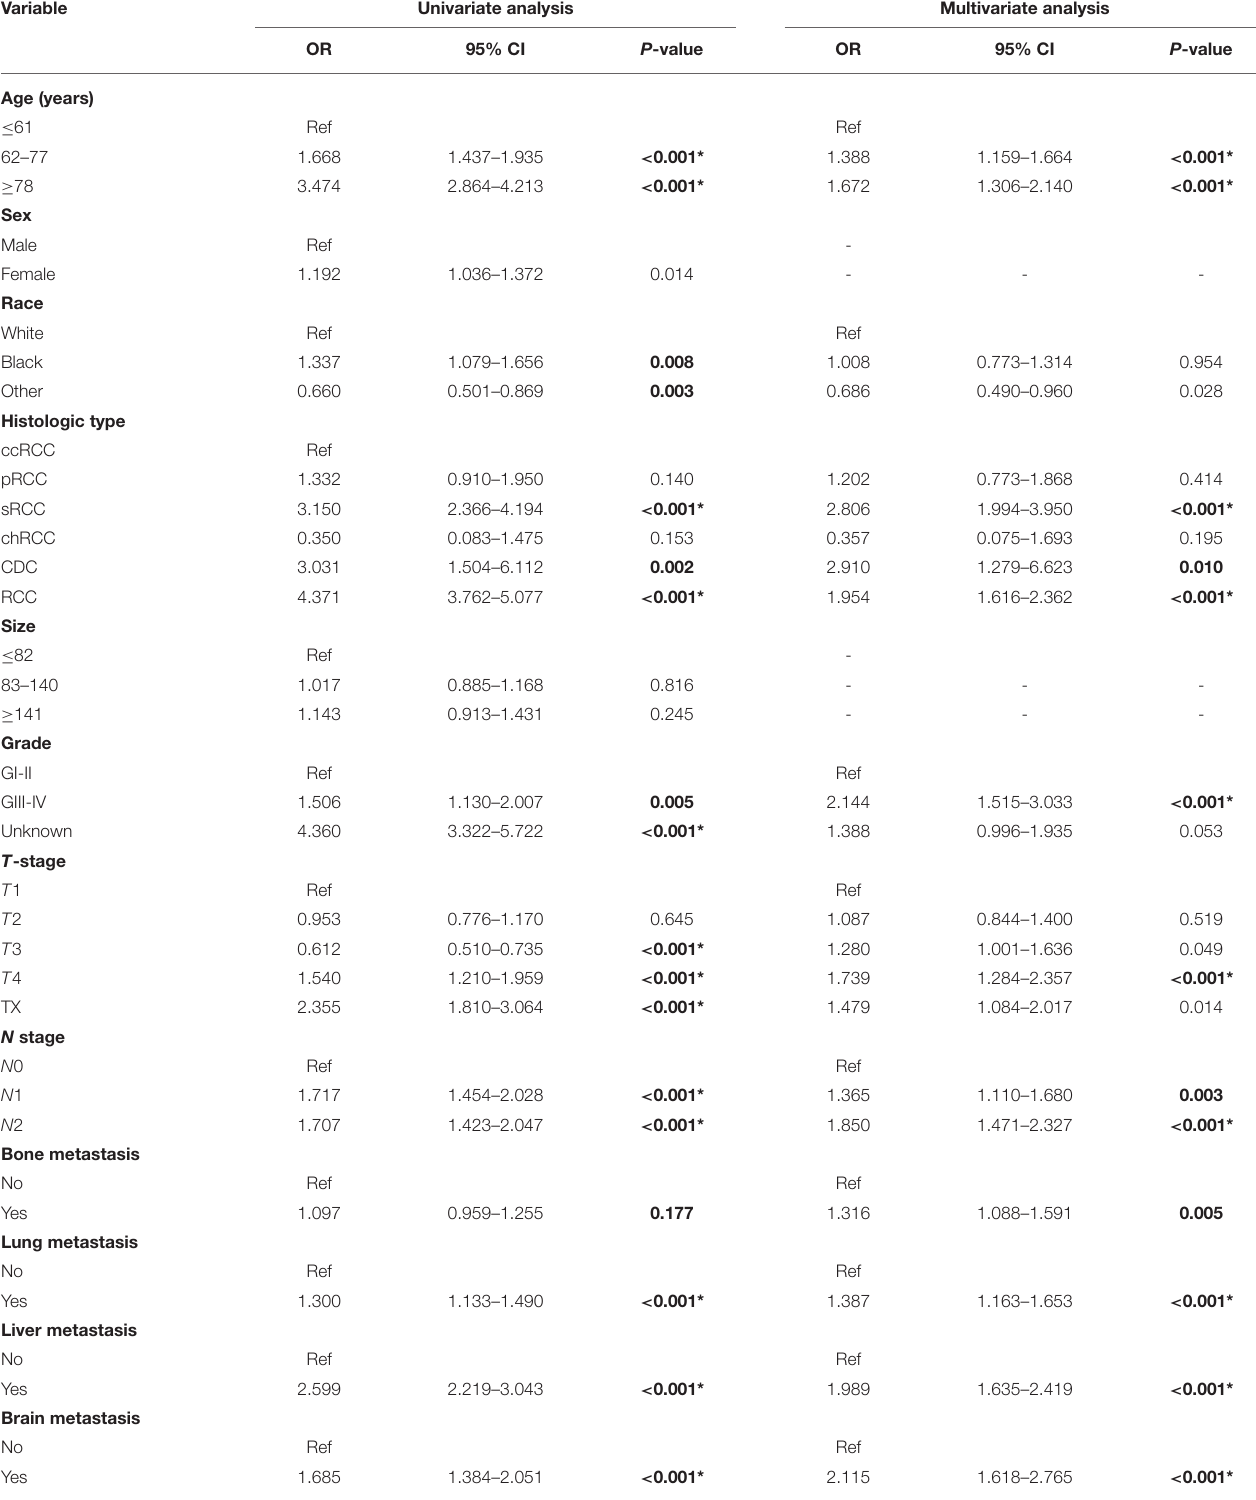
TABLE 3 | Univariate and multivariate logistic regression for identifying the risk factors for early death of mRCC.